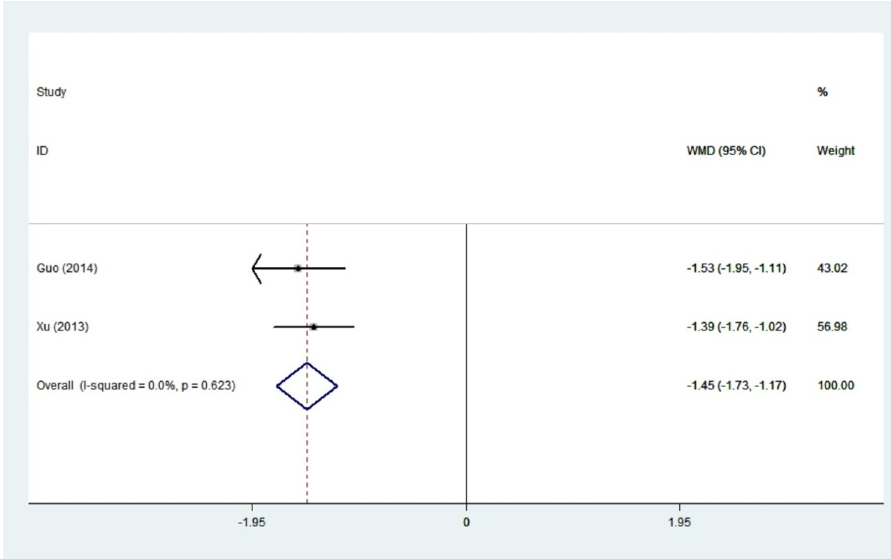
Fig 9. Forest plots of showing the effects of PTU on